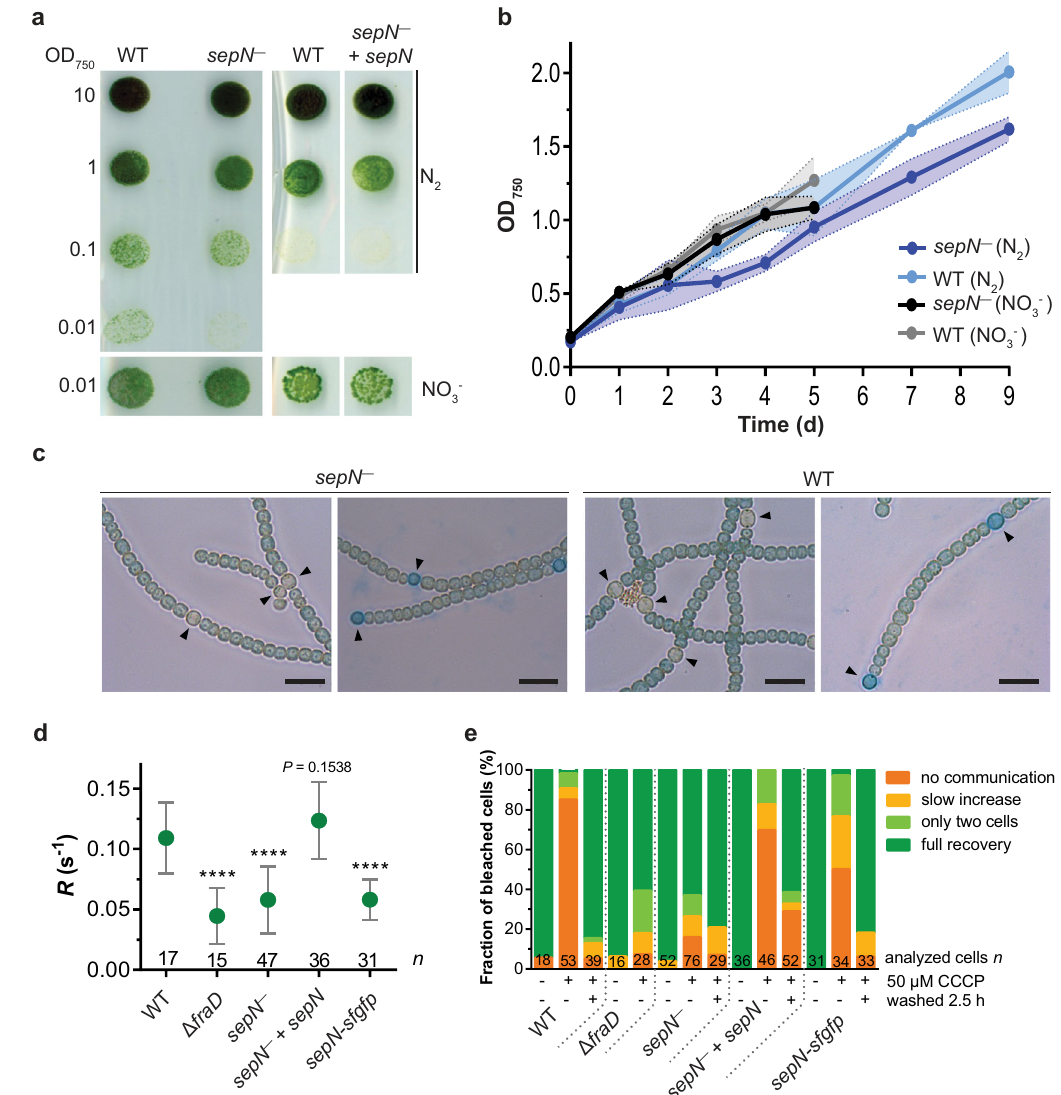
Fig. 3 | A sepN − mutant can grow diazotrophically but has impaired cell – cell communicationandgatingofseptaljunctions.a Spotted coloniesof the Nostoc WT, the sepN − mutant and the complemented mutant ( sepN − + sepN ) on nitrate- free medium (N 2 ) showed diazotrophic growth of sepN − mutant. Images were taken after 7days under standard cultivation conditions. b The growth rate in diazotrophicconditionsisdeceleratedina sepN − mutant.Nodifferencescouldbe observed in the growth of the mutant and the WT in the presence of nitrate (experimentwasrepeatedtwicewithbiologicallyreplicatesforWTandfourtimes for sepN − mutant). Mean values of OD 750 measurements (connected by solid line) +/ − standard deviation (shaded area) are shown. Two-sided t -test was performed ( p -value=0.8446 or 0.5322 for nitrate and nitrate-free conditions, respectively). Source data are provided as a Source Data fi le. c Liquid cultures of WT and sepN − mutant were analyzed via light microscopy 48h after transfer of the cultures to nitrate-free medium. The heterocyst polysaccharide layer was stained with Alican blue (respective right images). Both strains were able to form heterocysts (indi- cated by black arrowheads). Bars, 10 μ m. Experiment was performed twice with similar results. d The fl uorescence recovery rate constant R of diverse Nostoc strains after FRAP treatment. The sepN − mutant as well as the sepN-sfGFP strain